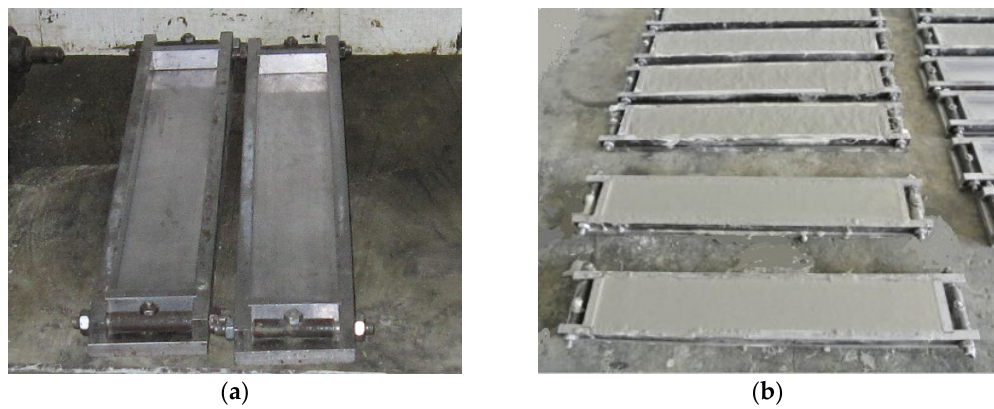
Figure 10. Molds and samples for four-point bending test. ( a ) Coupon molds; ( b ) molded specimens.